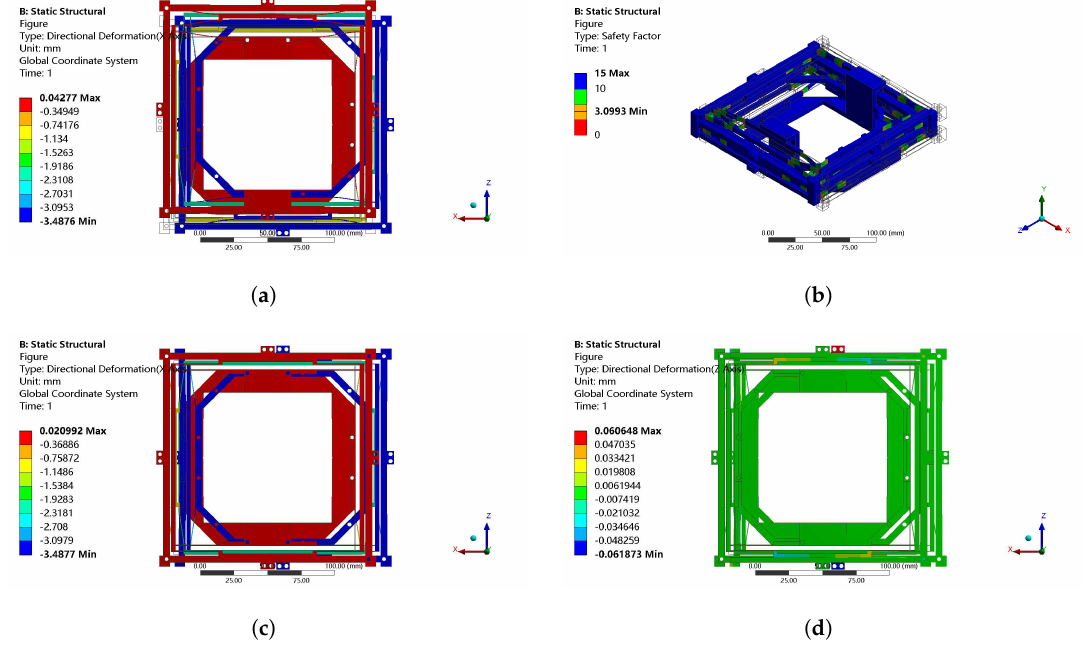
Figure 8. Finite-element simulation results. ( a ) Total deformation on x-axis, ( b ) safety factor, ( c ) result of motion decoupling, and ( d ) result of undesired deformation.